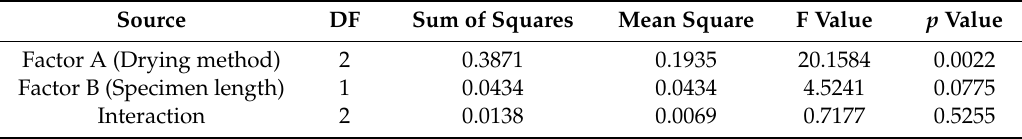
Figure 7. Drying stress of specimens under different treatment conditions. Table 7. Two-way analysis of variance with drying